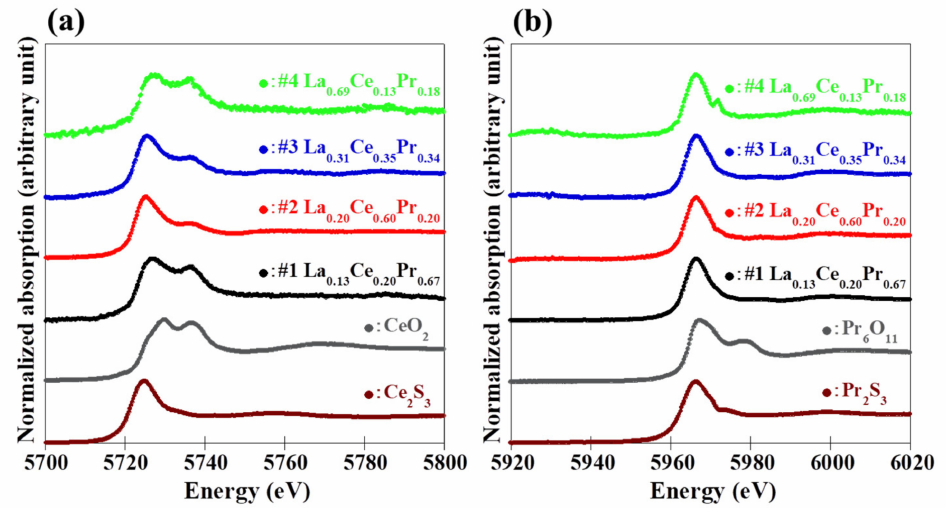
Figure 5. ( a ) Ce L 3 -edge and ( b ) Pr L 3 -edge absorption spectra using XAFS spectroscopy at room temperature for the grown (La,Ce,Pr)OBiS 2 single crystals and standard samples for each valence state (Ce 3+ : Ce 2 S 3 ; Ce 4+ : CeO 2 ; and Pr 3+ : Pr 2 S 3 ; Pr 4+ : Pr 6 O 11